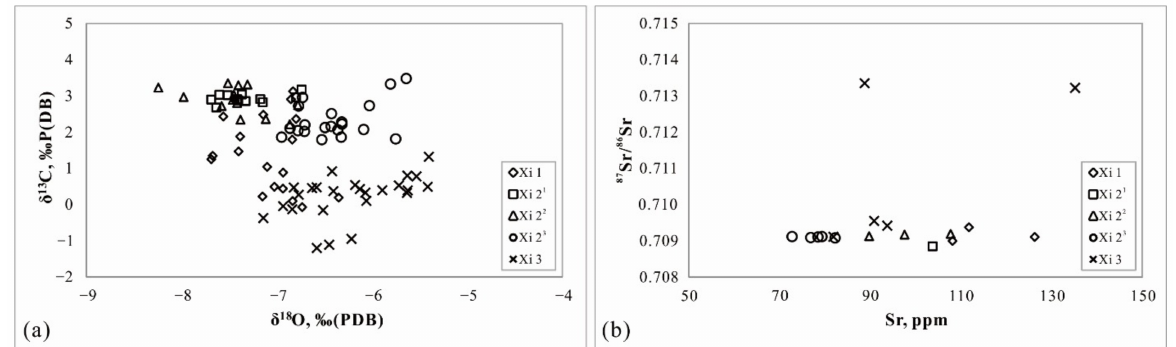
Figure 5. Binary plots of Geochemistry in Xiaoerblak Formation dolomite: ( a ) δ 13 C versus δ 18 O; ( b ) 87 Sr/ 86 Sr versus Sr